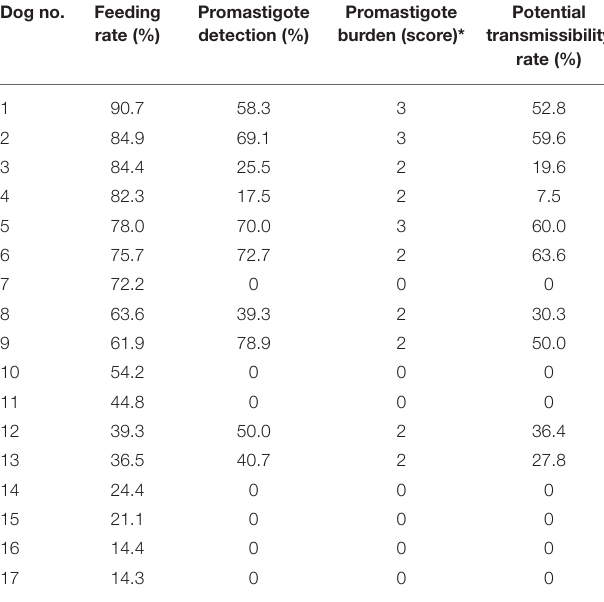
TABLE 4A and B | Analysis of the relationship of laboratory and clinical dog’s parameters with sand flies’ parameters. (A) Dog variable Sand fly